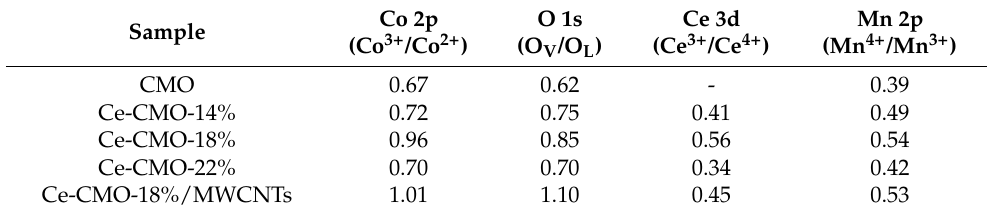
Figure 2. The XPS spectra of CMO, Ce-CMO-14%, Ce-CMO-18%, and Ce-CMO-22% electrocatalysts: ( a ) Co 2p, ( b ) O 1s, and ( c ) Ce 3d. Table 1. The valence state distribution of Co 2p, O 1s, Ce 3d, and Mn